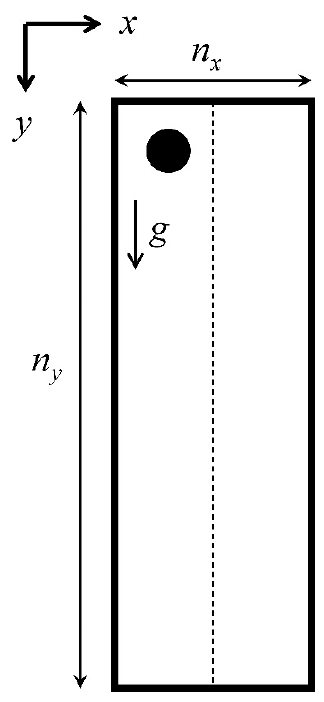
Figure 8. Schematic of a single particle settling under gravity.